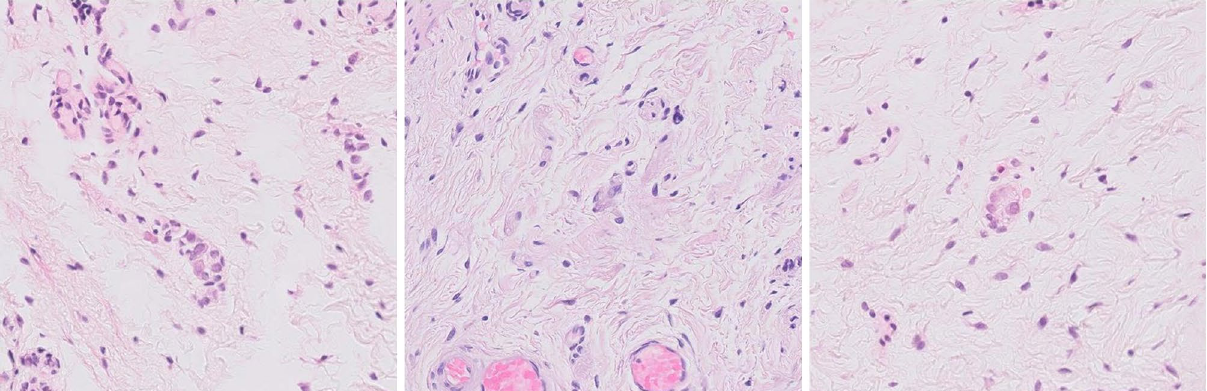
Figure 3. Examples of non-specific findings, mistaken for ganglion cells by non-expert pathologists. Without proper context, these findings may mimic immature ganglion cells. However, many of these findings were in fact within the mucosa or serosa, bowel layers normally devoid of ganglion cells, thus ruling out any "ganglion cells" seen within